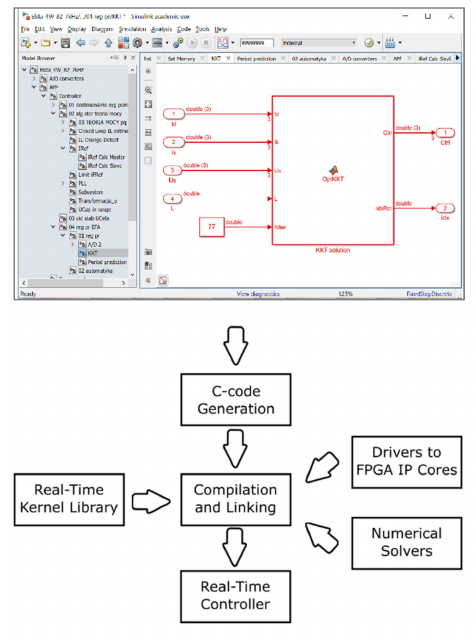
Figure 6. Automatic generation of real-time